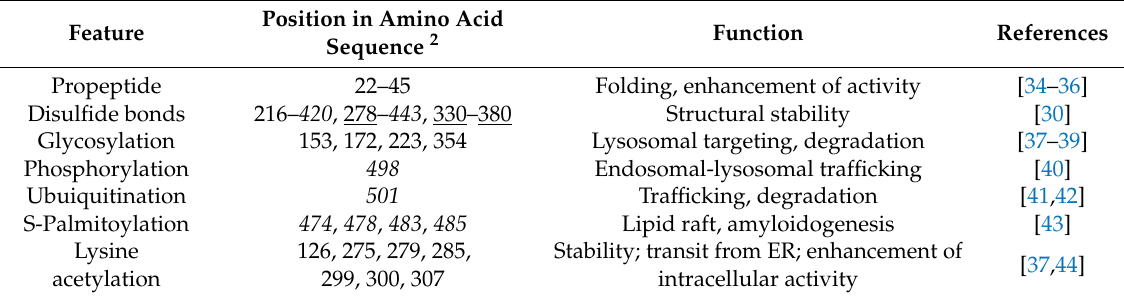
Table 1. Post-translational modifications observed for BACE1 1